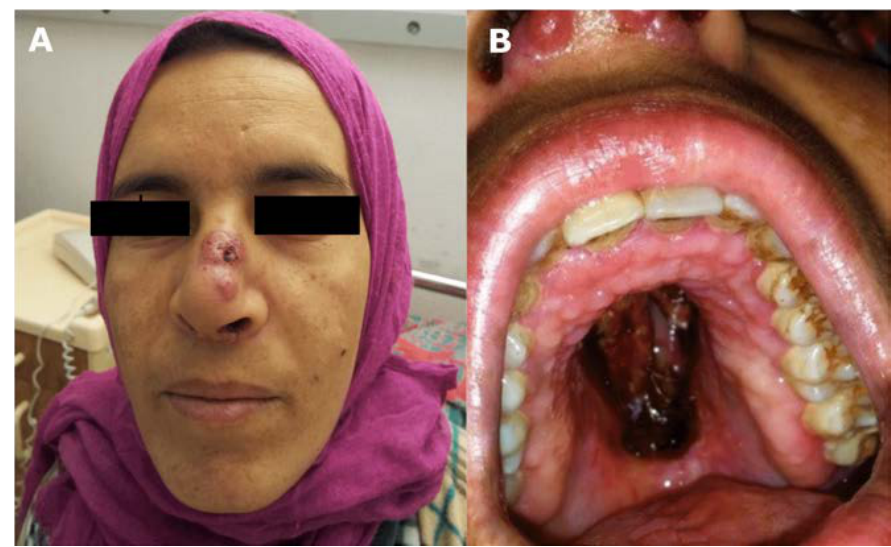
Figure 1. Painful erythematous lesions of the dorsum nasi ( A ) and necrotic lesions of the hard palate ( B ) due to Alternaria infectoria in a patient with CARD9 deficiency.